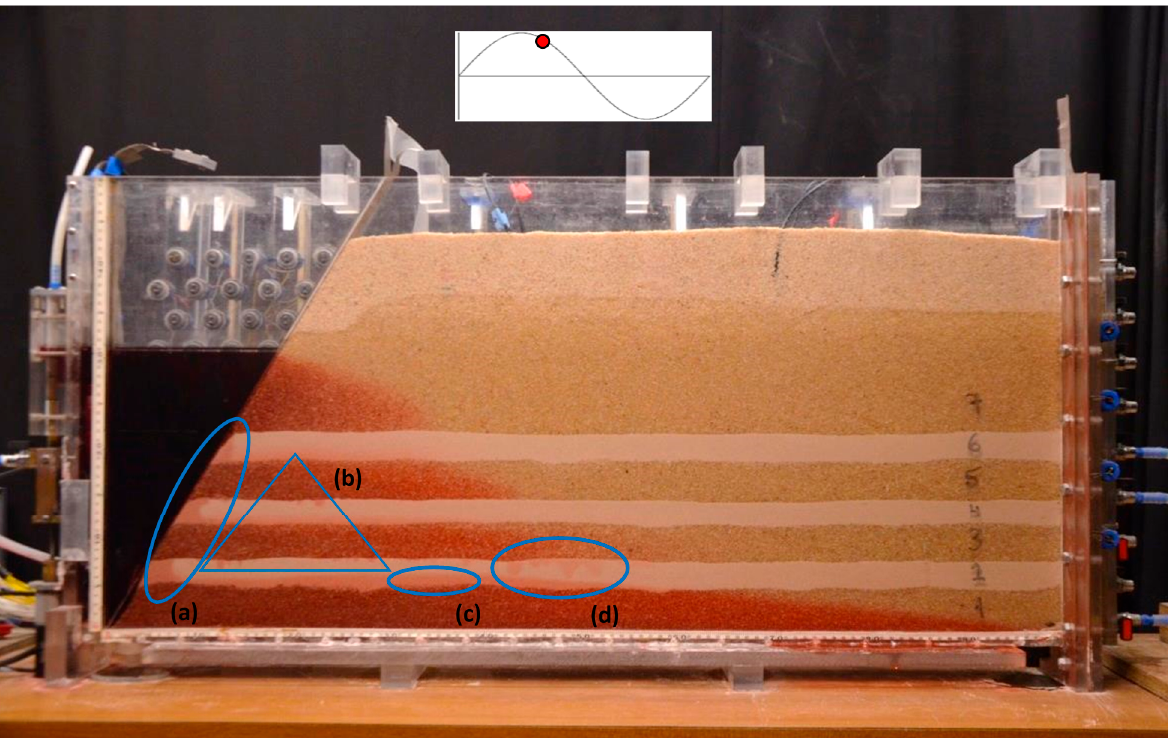
Figure 7. Several mixing mechanisms at the aquitards during high tide, E3-180: ( a ) restricted horizontal flow; ( b ) haline convection, namely downward salt fingers from the above aquifers; ( c ) upward salty front; ( d ) flushing of freshwater fingers into saline pockets. This snapshot was taken slightly after the high tide (box at the top), when the seawater intrusion is maximal.